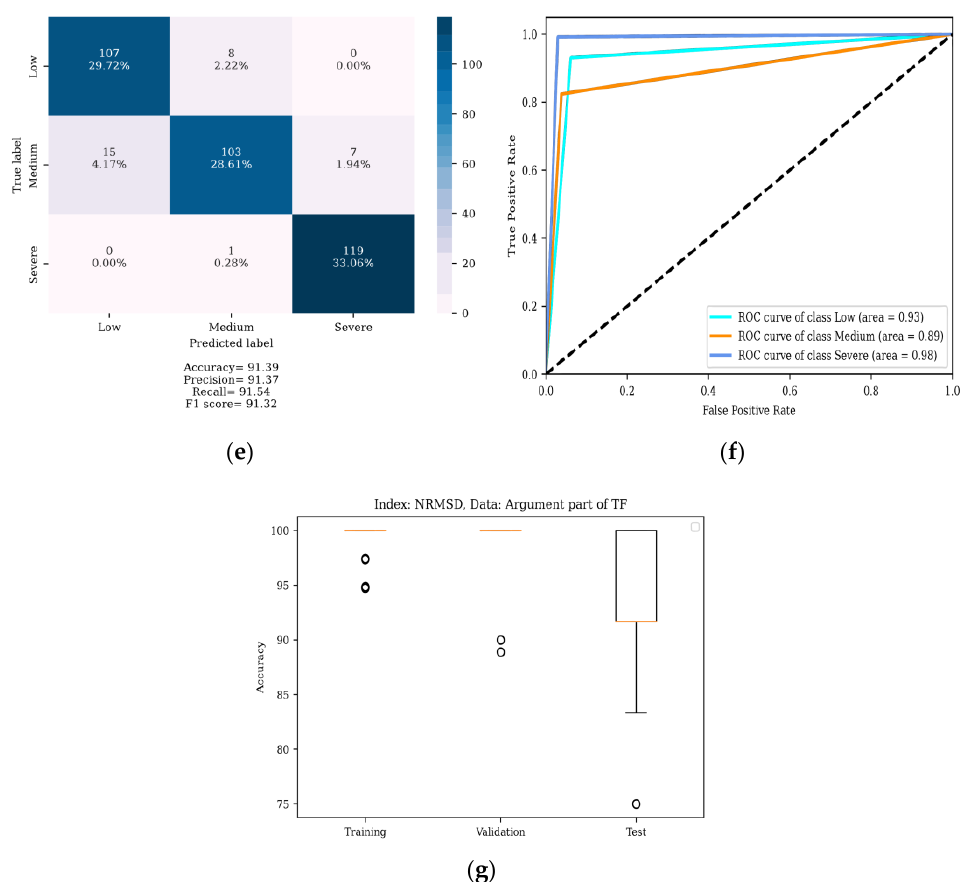
Figure 26. MLP performance in determining the severity of the DSV fault using the extracted features from the phase part of the TF using the NRMSD index: ( a ) training confusion matrix; ( b ) training ROC curve; ( c ) validation confusion matrix; ( d ) validation ROC curve; ( e ) test confusion matrix; ( f ) test ROC curve; ( g ) box plot of the training, validation, and test accuracies in thirty iterations.